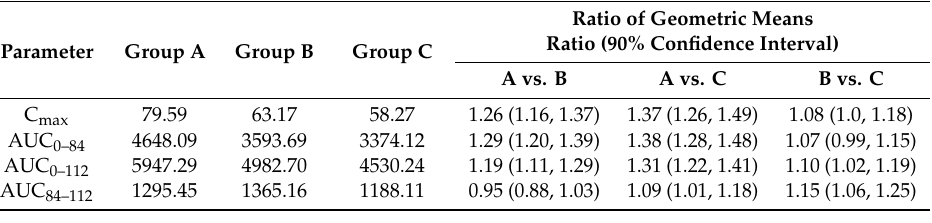
Table 2. Pharmacokinetics parameters determined from the serum 25 (OH)D concentration.